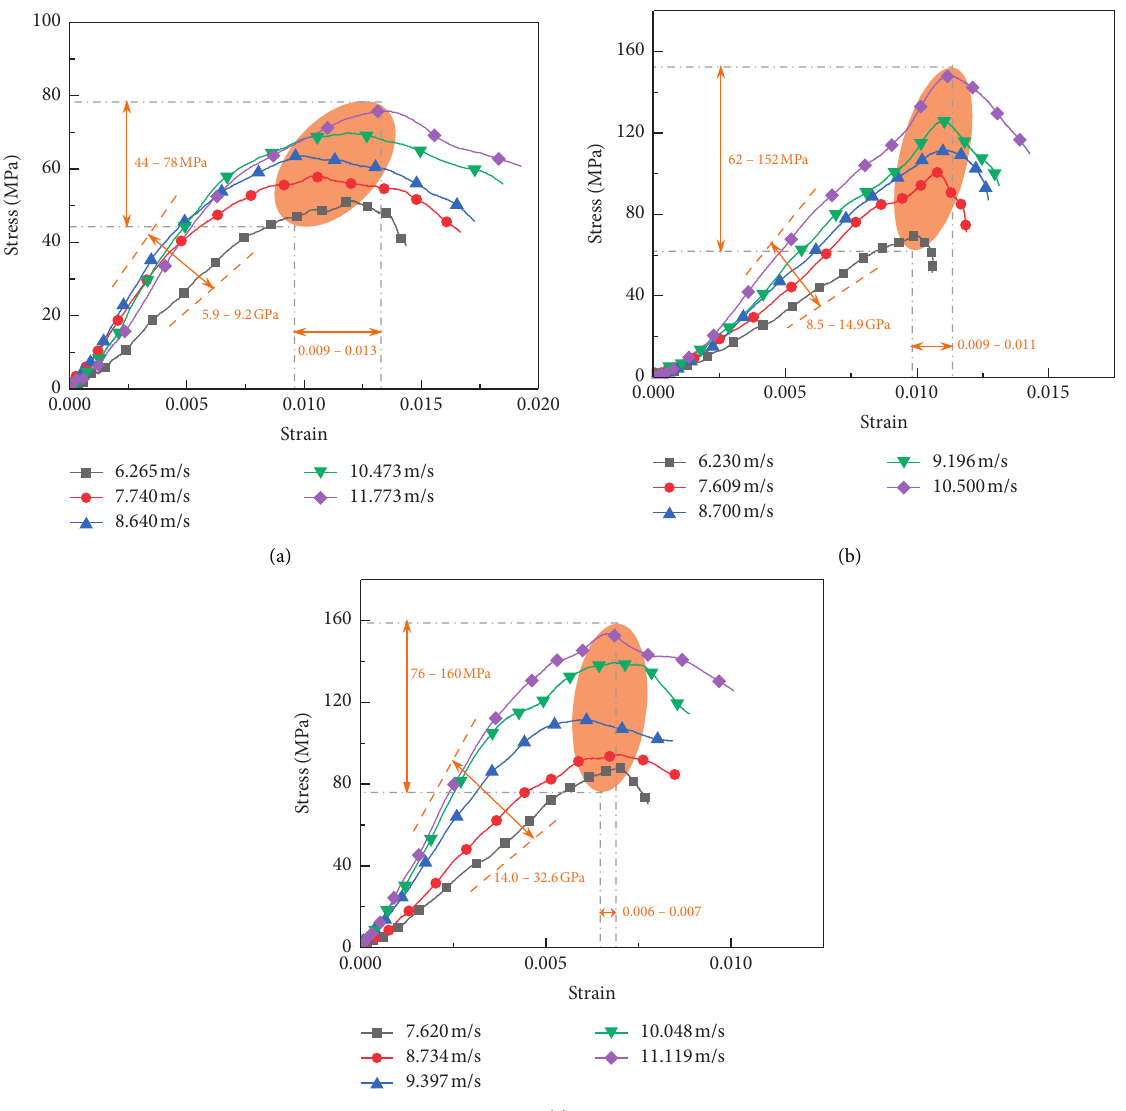
Figure 6: Stress-strain curve: (a) red sandstone, (b) gray sandstone, and (c)